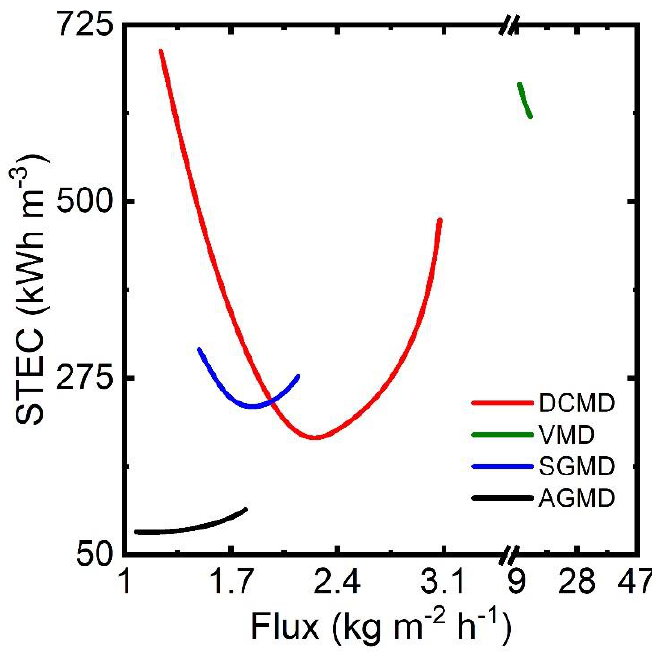
Figure 14. Flux vs. STEC in MD-based desalination.